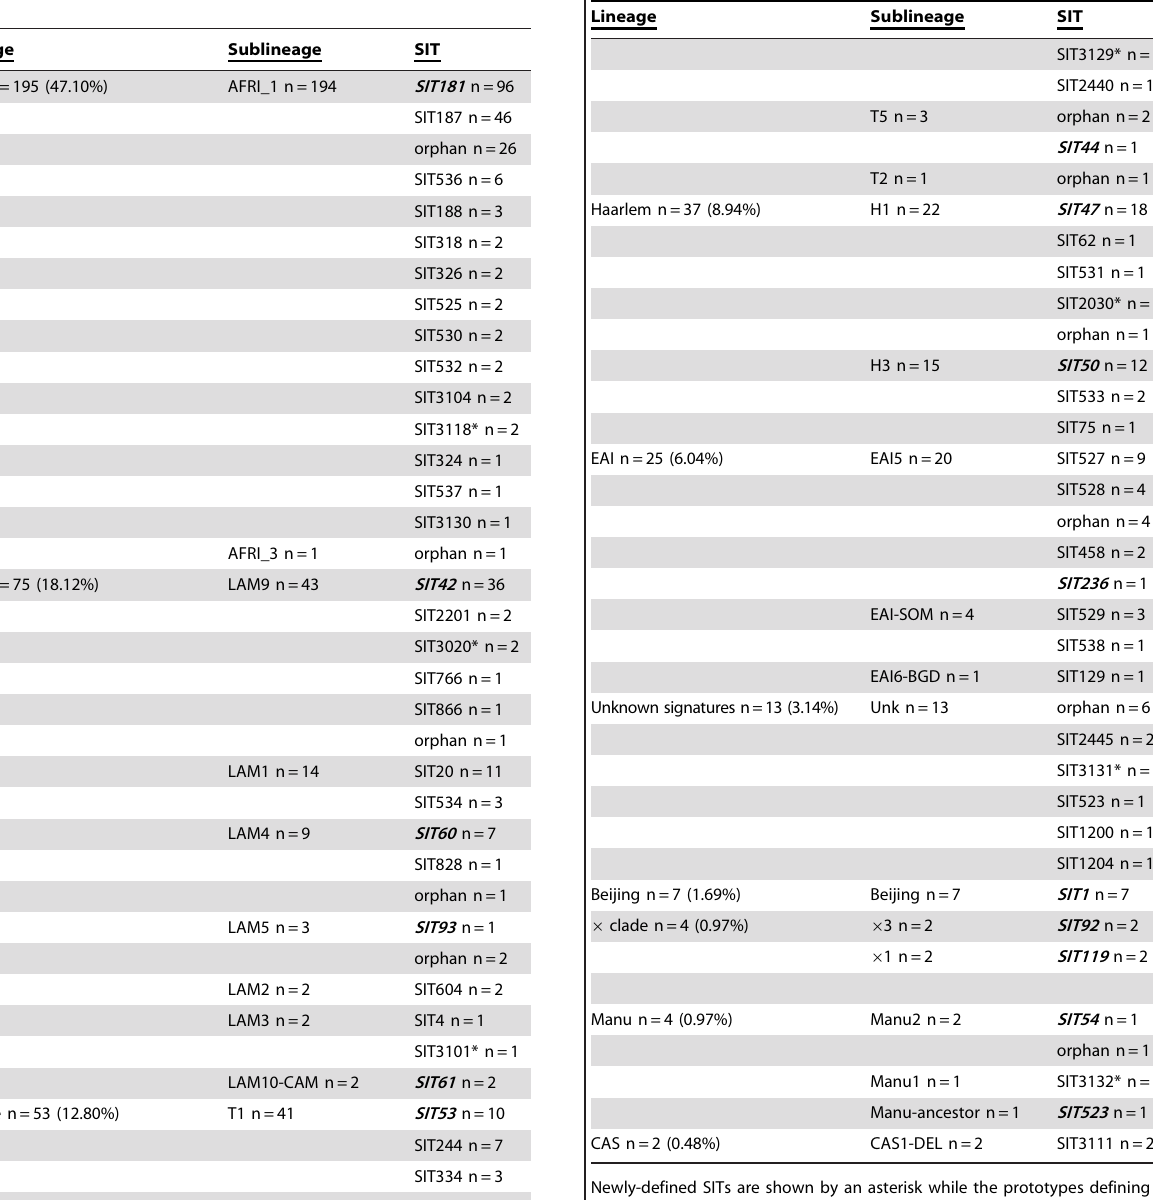
Table 1. Sublineage distribution and associated SIT designations for each of the lineages in the